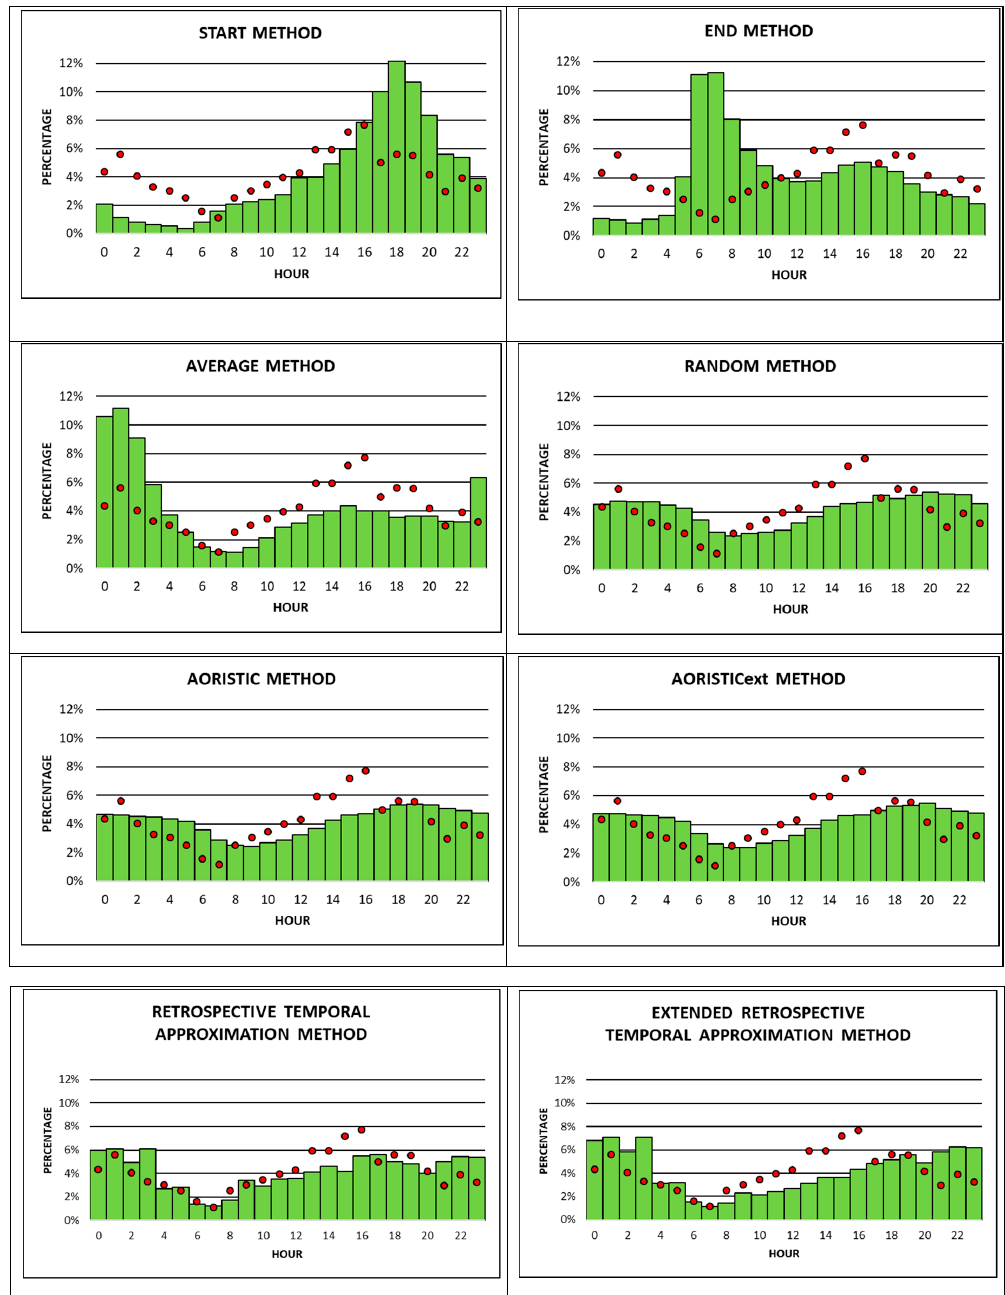
Figure 5. Comparing observed (red dots) and estimated (green bars) occurrence times of car burglaries in Vienna, Austria between 2013–2015.